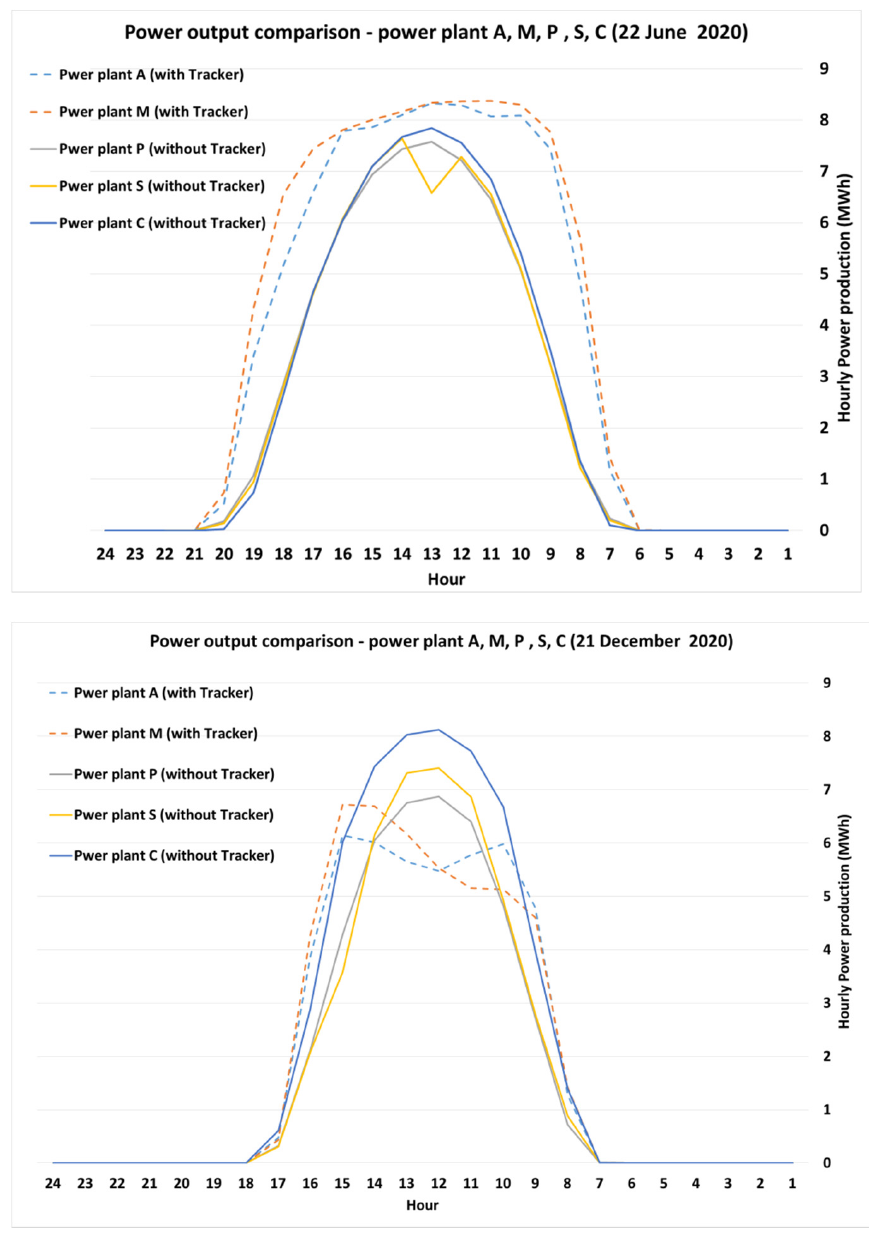
Figure 8. Daily energy production of five 10 MW solar power plants on 22 June and 21 December 2020, in Yazd province.